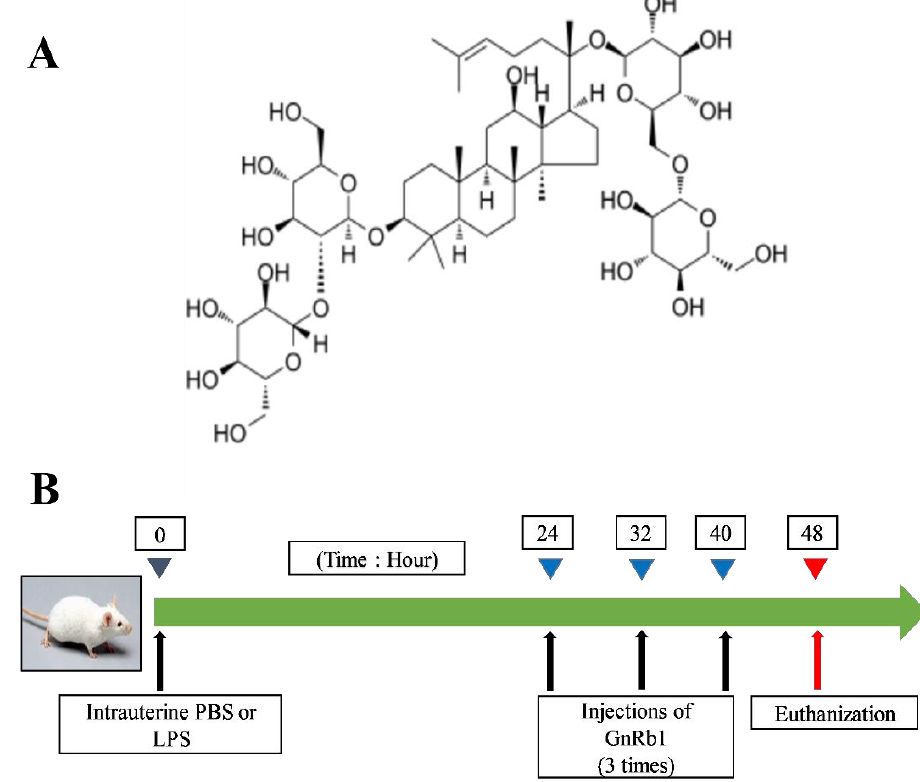
Figure 1. ( A ) The structure of Ginsenoside Rb1. ( B ) Animal treatment protocol of this study.